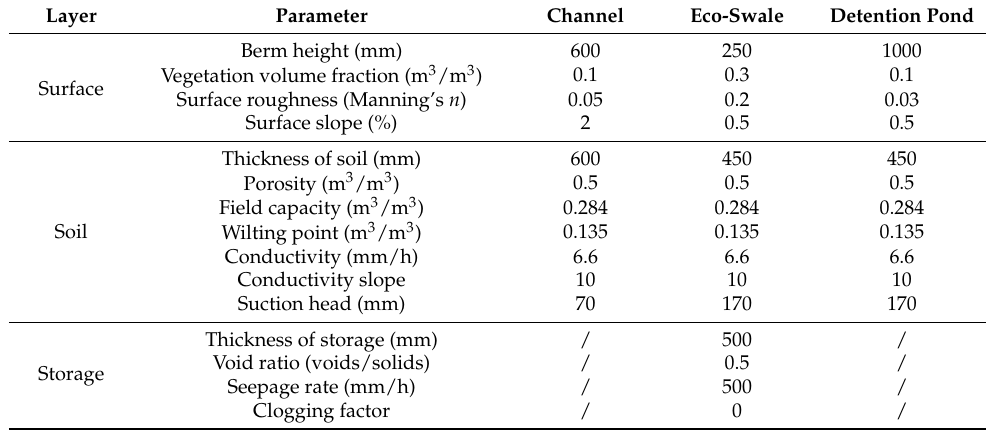
Table 3. Parameters used for multi-level controls in the SWMM